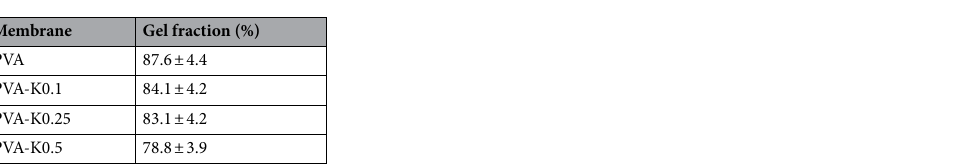
Table 2. Gel fractions of the PVA hydrogel membrane and PVA/Kaolin composite hydrogel membranes. Data are presented as means ± SD.